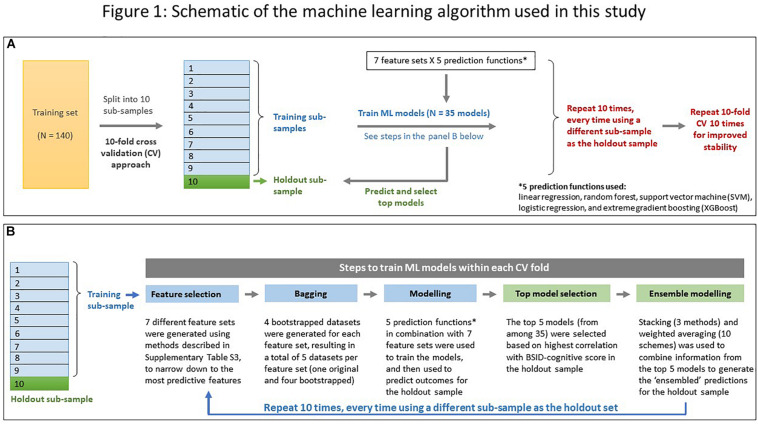
Schematic of the machine learning algorithm used in this study. (A) A 10-fold cross validation (CV) approach was used. The training dataset (N = 140) was randomly split into ten “folds.” During each CV run, data from ninefold were combined to form the training subsample while the remaining fold was used as the holdout sample. Operations in the training sub-sample are coded in blue, and those in the holdout sample in green. The 10-fold CV was repeated 10 times for improved stability. (B) Details of the five steps employed in each CV run while predicting a child’s cognitive score. Color coding same as in (A).